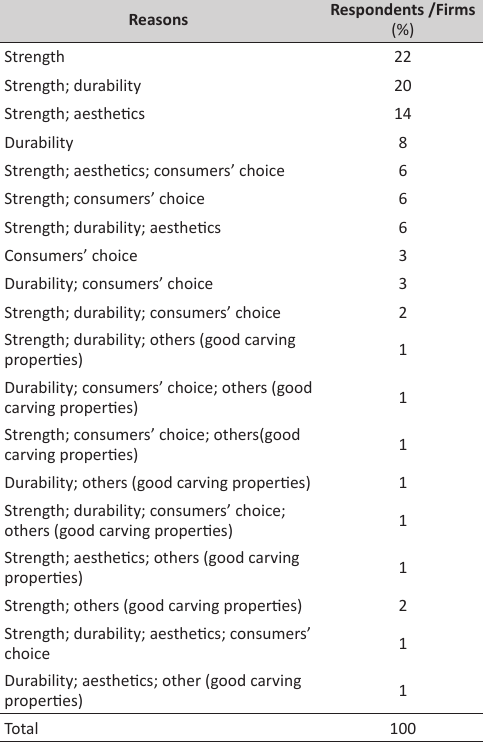
TaBLe 3. Reasons for choice of timber used for furniture manufacturing